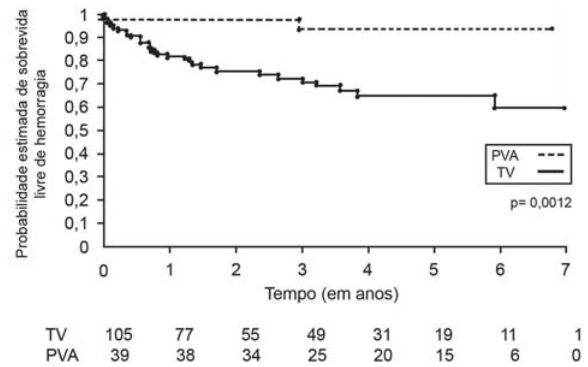
Fig. 4 - Curvas de sobrevida livre de complicações